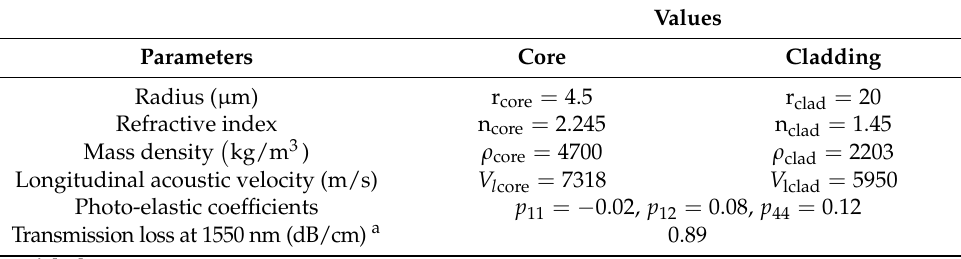
Figure 1. Schematic diagram of Brillouin scattering in lithium niobate optical fiber, the distribution of LP 01 , LP 11 , and LP 21 optical modes in the core region, and the distribution of L 01 , L 11 , and L 21 acoustic modes in the core and cladding regions. Table 1. Structure and material parameters for the SIF.